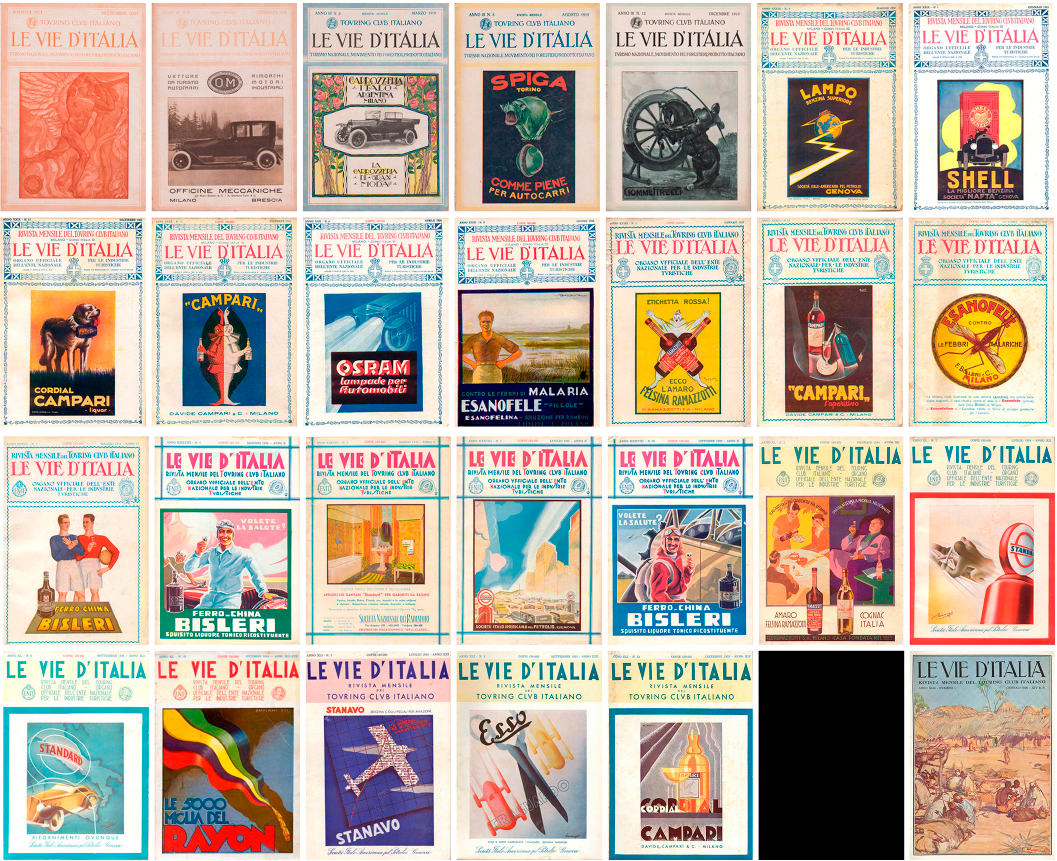
Figure 8. The “landscape of Italian products” that the covers progressively assemble up through January 1936 when the Mercato a Belet Uen sull’Uebi Scebeli by Giorgio Oprandi spelt the end of the very original